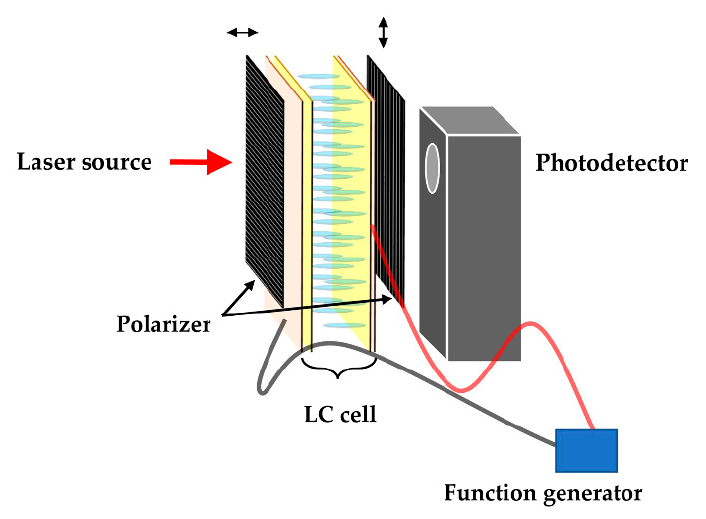
Figure 2. Schematic diagram of electro-optical measurement system.